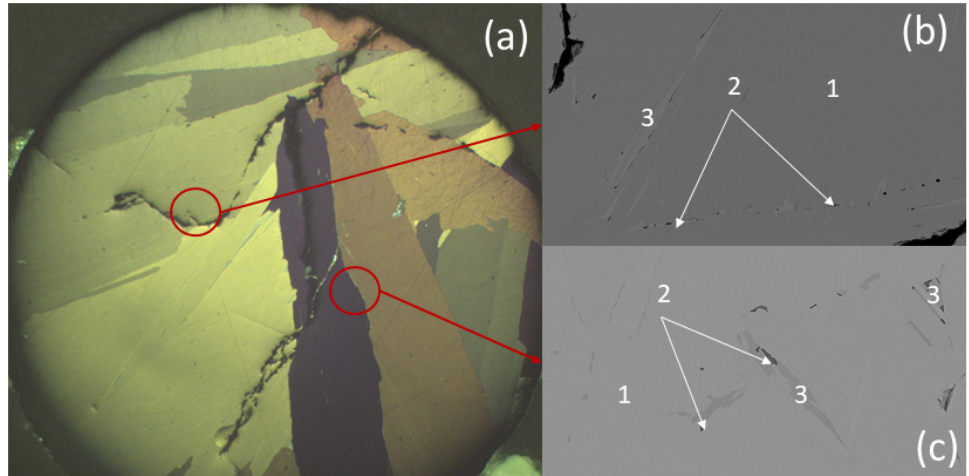
Figure 5. ( a ) Polarized microscopy image of a cross-section of La 1.51 Sr 0.19 Eu 0.3 CuO 4 grown using Eu-free, Cu-poor solvent. ( b , c ) SEM backscattered electron images corresponding to the areas marked on the left panel, where: 1—La 1.51 Eu 0.3 Sr 0.19 CuO 4 ; 2—areas enriched with Sr; 3—areas enriched with Eu.